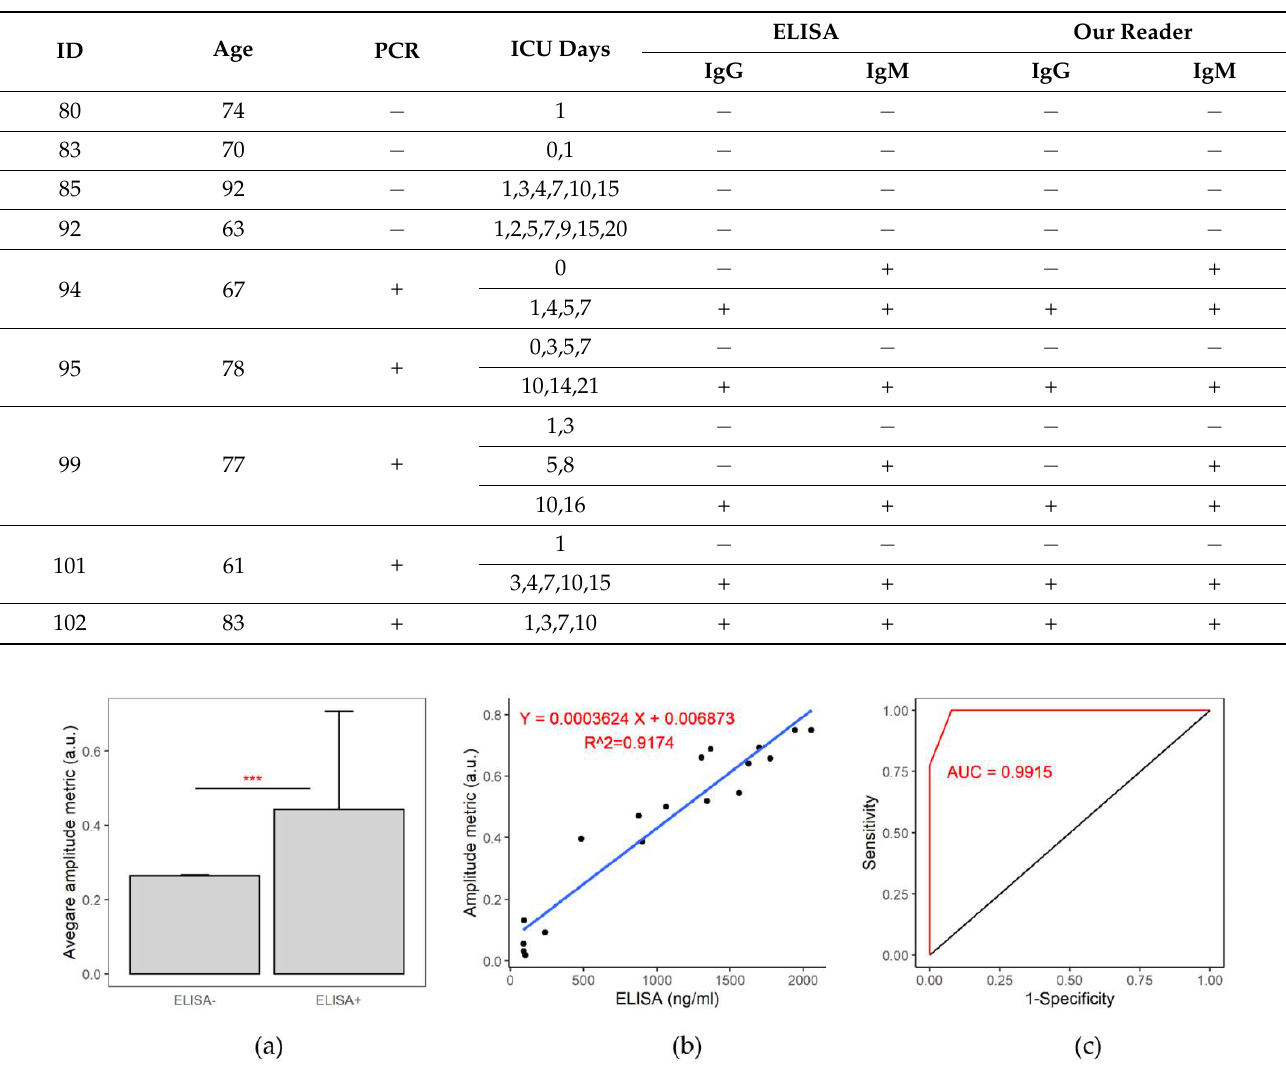
Table 1. Demographic information of patients and test results with the ELISA and thermo-photonic reader. Sign + refers to a positive test and − sign refers to a negative test.